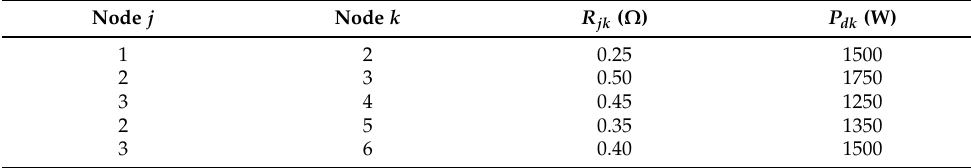
Table 5. Branch and load parameters for the six-bus grid in monopolar DC